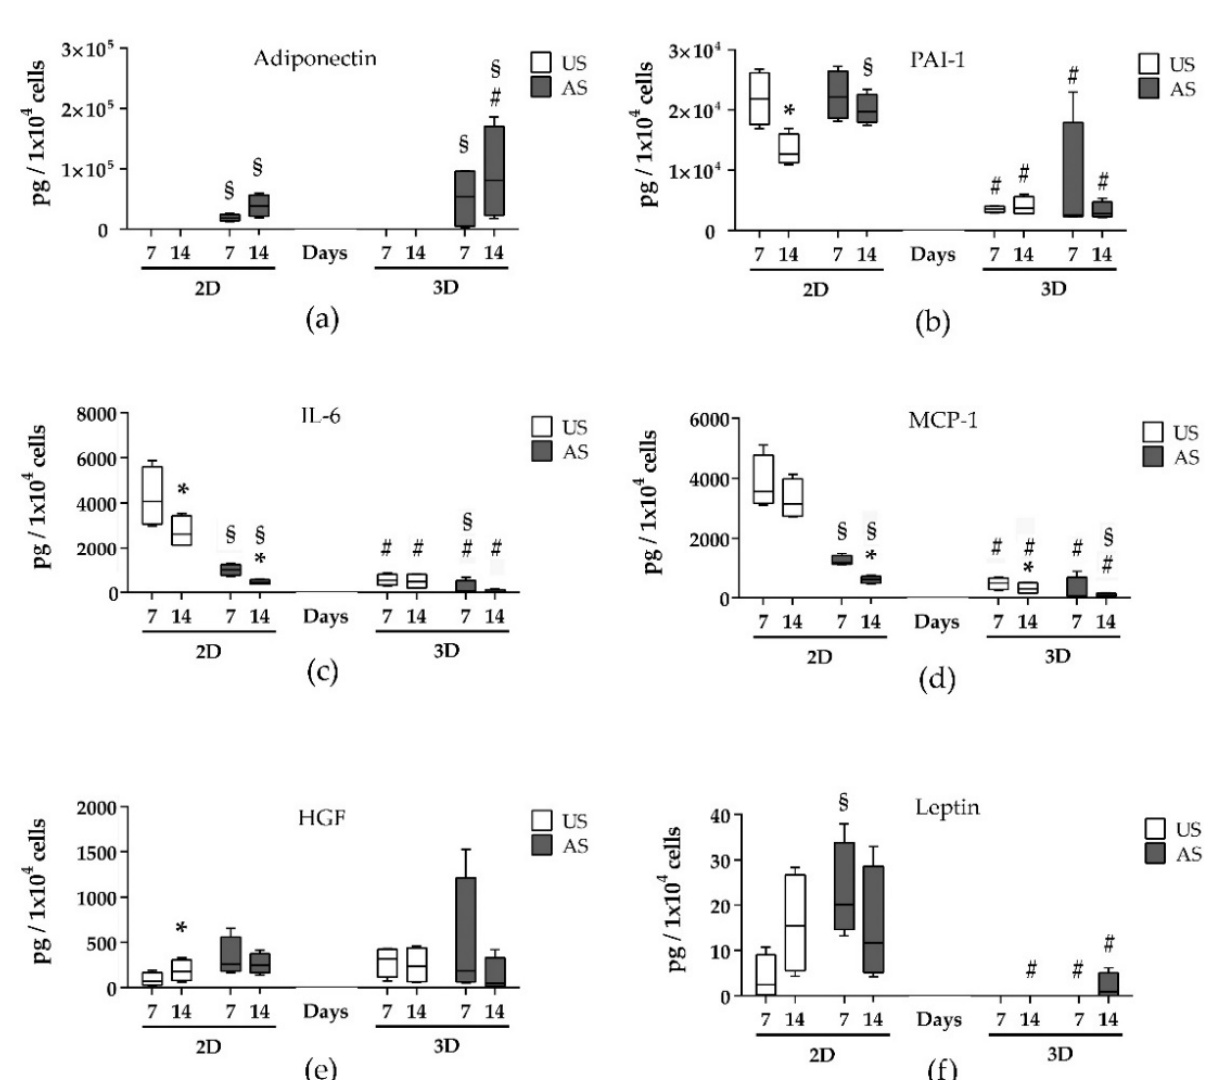
Figure 5. Quantification of adipokines in supernatants of unstimulated (US) and adipogenically (AS) stimulated 2D and 3D cultures after 7 and 14 days. ( a ) Adiponectin; ( b ) PAI-1; ( c ) IL-6; ( d ) MCP-1; ( e ) HGF; ( f ) leptin (concentrations were normalized to cell number, n = 4; # significantly different from 2D cultures at the respective time point; * significantly different from day 7 under the same